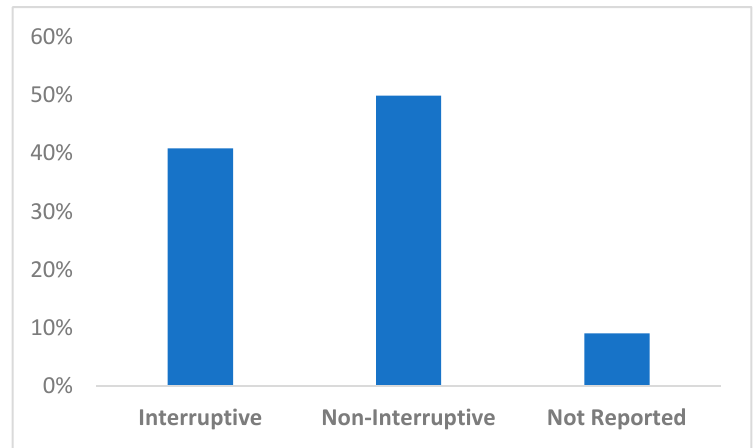
Figure 3. Distribution of risk score presentation from predictive models within electronic health record (EHR) systems when classified as interruptive or non-interruptive.